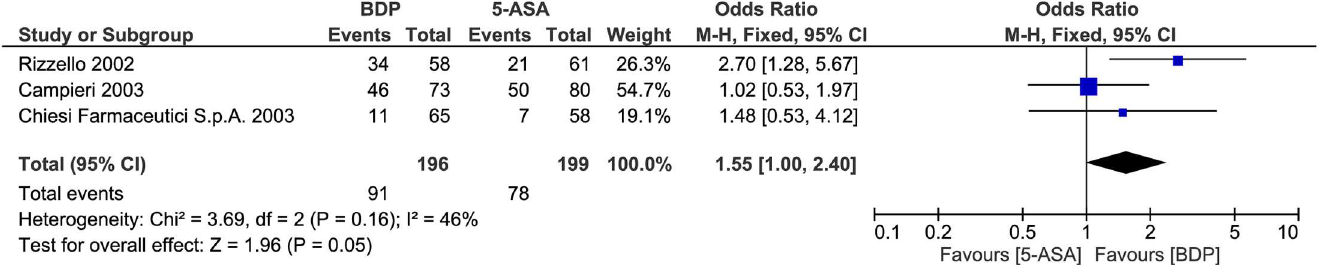
Fig 7. Forest plot of randomized controlled trials of oral BDP vs. oral 5-ASA in inducing clinical remission in ulcerative colitis. BDP, beclomethasone dipropionate. 5-ASA, mesalazine.M-H, Mantel-Haenszel.